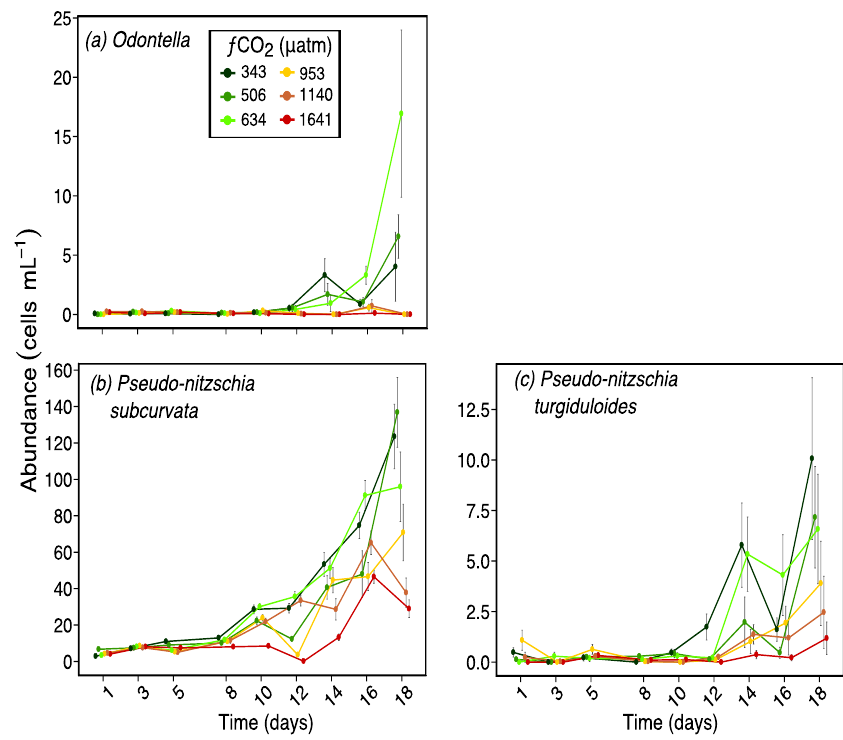
Figure 5. Abundances of (a) Odontella spp. (pervalve length ≈ 70µm); (b) Pseudo-nitzschia subcurvata ( ≈ 55µm in length); and (c) Pseudo- nitzschia turgiduloides ( ≈ 85µm in length) over days 1 to 18 of the incubation of a natural protistan community in tanks maintained at different f CO 2 levels. Error bars are standard errors derived from pseudo-replicates undertaken at each time point for each